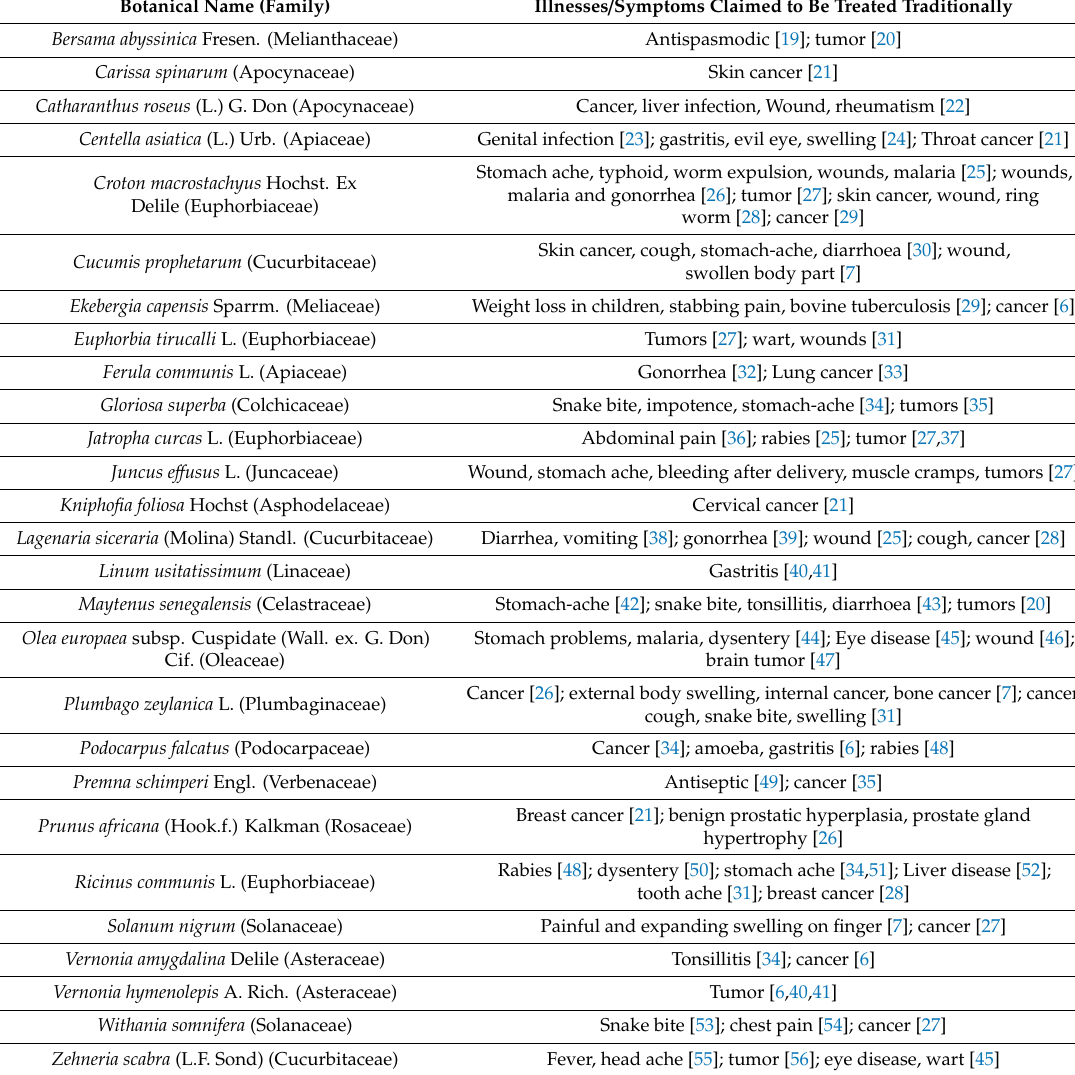
Figure 1. Major plant families (in %) of reviewed plants species vegetation zone of Ethiopia [18] (the unmarked blocks are other species). Table 1. General traditional use of selected Ethiopian medicinal plants.